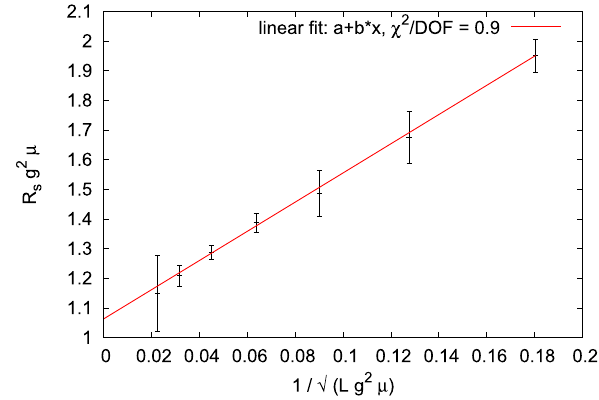
Fig. 5 Dependence of the saturation radius extracted from the data from Fig. 4 as a function of the fourth root of the volume. Approximate linear scaling can be seen pointing to a very mild suppression of finite volume effects